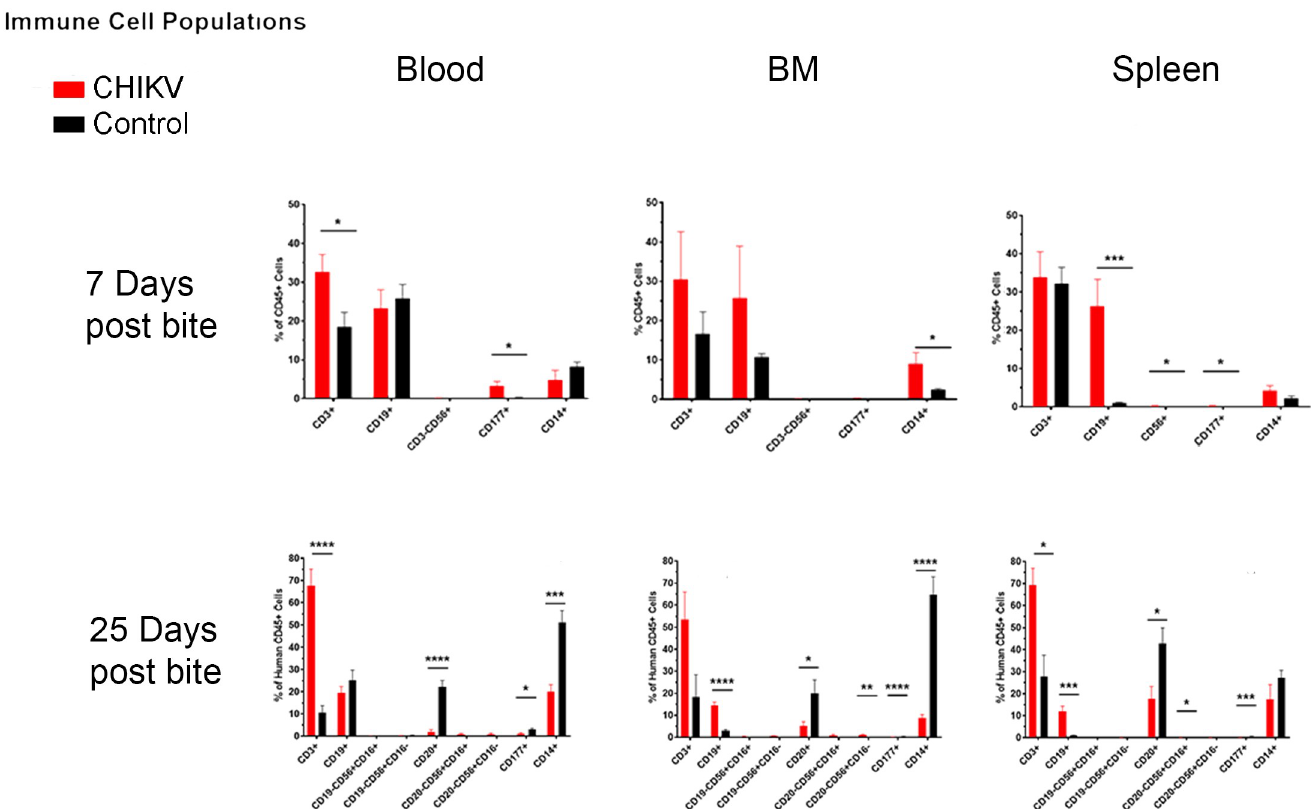
Fig 7. Summary of significant flow cytometry results (Immune cell populations: B cells, T cells, NK cells, and neutrophils) comparing Hu-NSG mice bitten by infected mosquitoes versus those bitten with control (uninfected) mosquitoes. Hu-NSG mice were infected with CHIKV via mosquito bite. At 7 and 25 days post- infection, mice were euthanized, and changes in immune cell populations in the blood, spleen, and bone marrow between infected and control mice were assessed via flow cytometry. Outliers were removed via ROUT analysis, and statistical significance was assessed via multiple comparison t-test using the Holm-Sidak correction. Immune components are outlined in the graphs above and summarized in table 5. Asterisks indicate significance differences (n.s. = not significant; � p < 0.05; �� p < 0.01; ��� p <